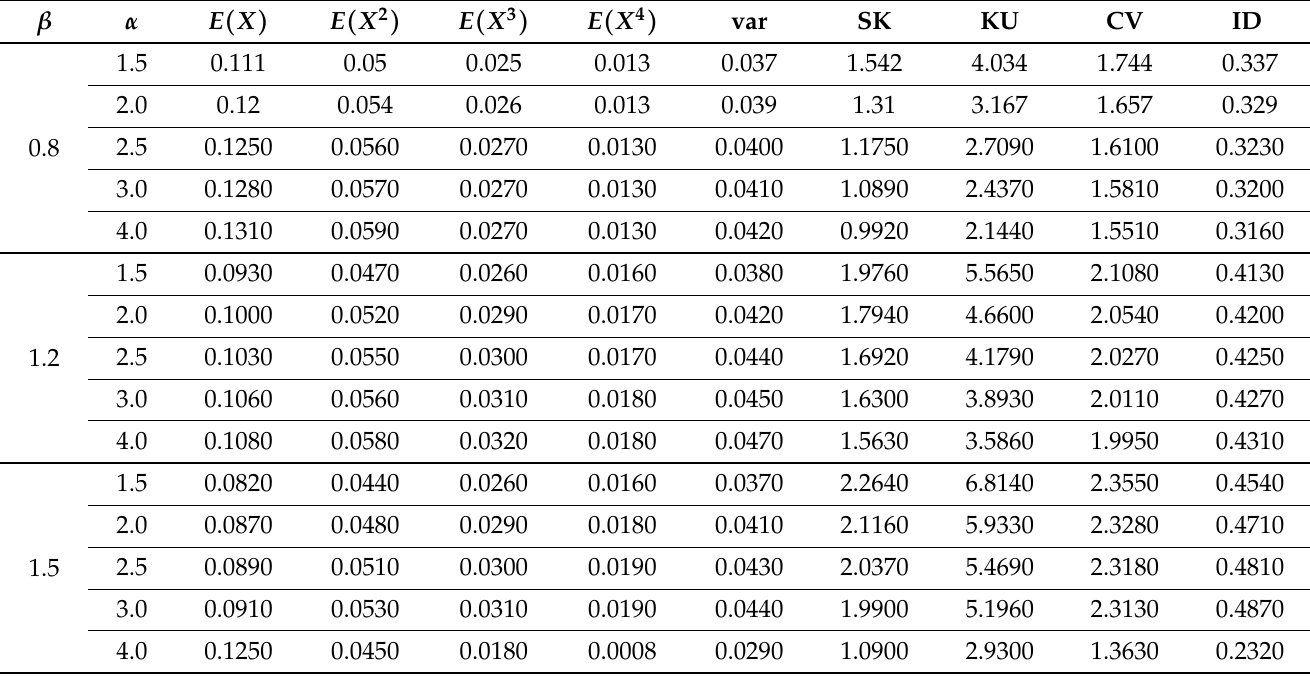
Table 1. Some numerical values of moments for the UEPD at λ =